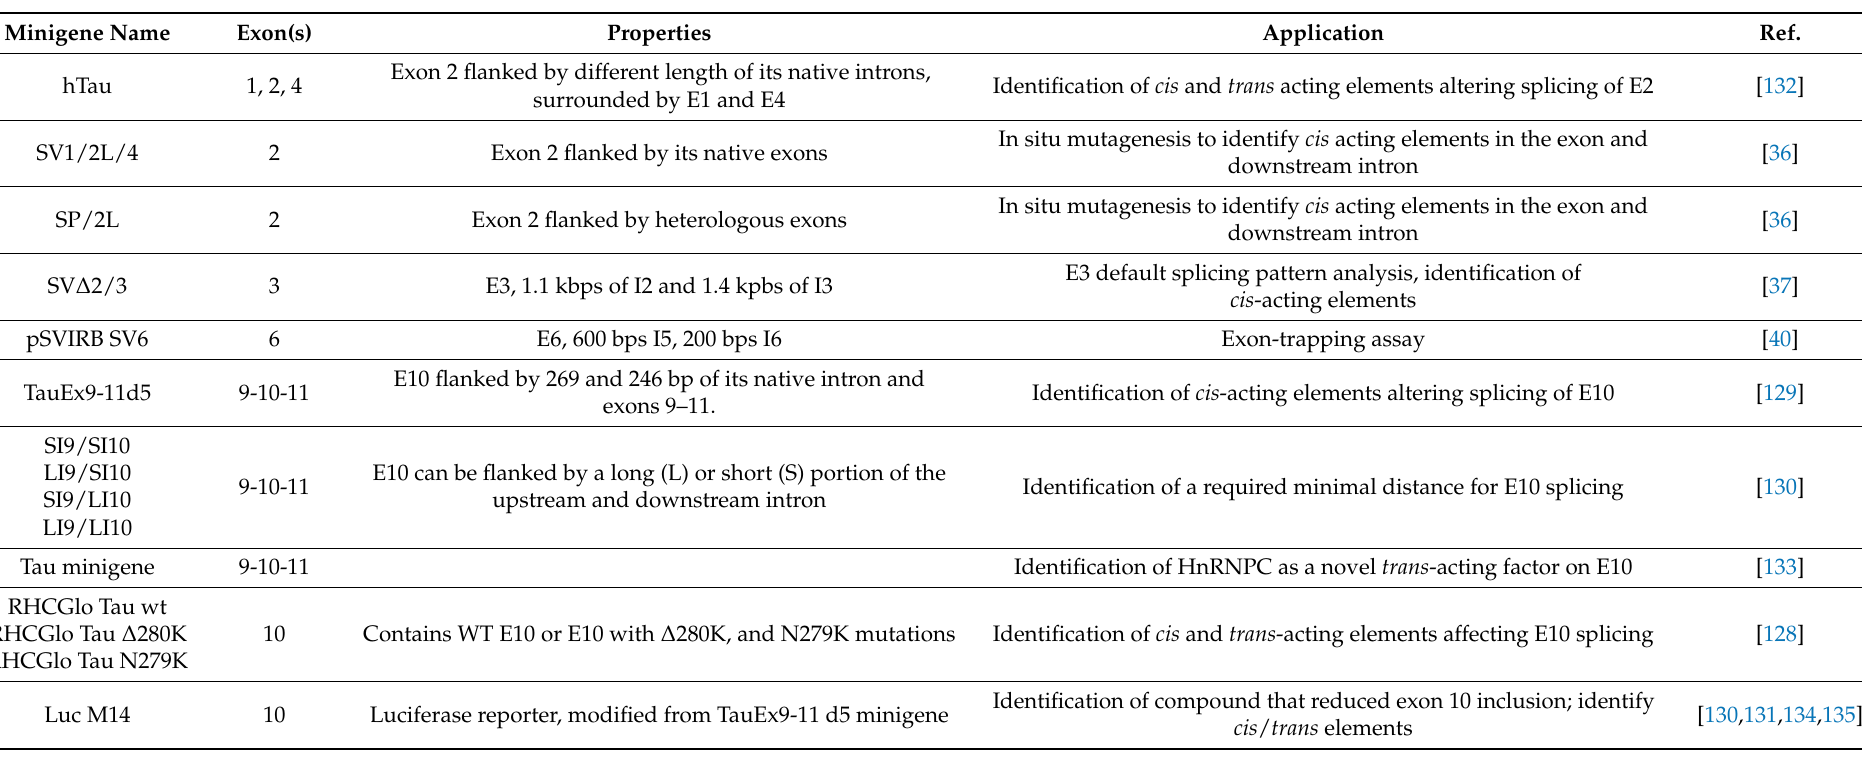
Table 1. Mini-reporter genes for Tau exons splicing